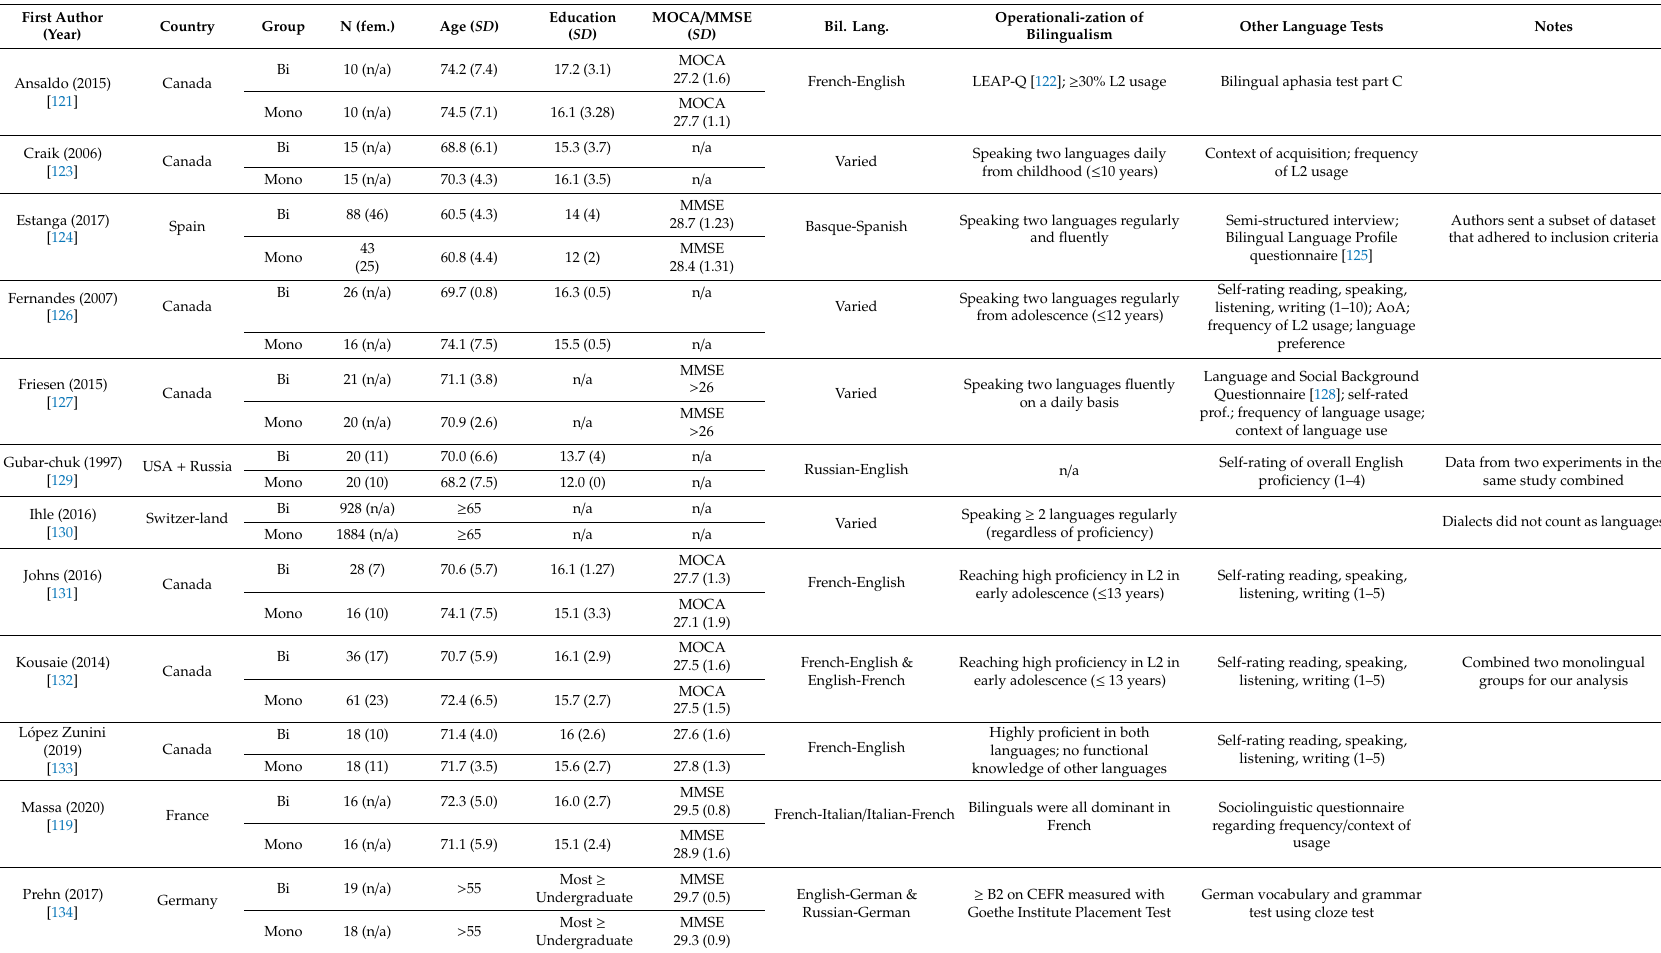
Table 3. Study characteristics of individual studies on cognitive function in bilingualism and in language learning interventions. Demographic information includes where the study took place, participants’ age and gender, educational background, and performance on Montreal cognitive assessment or the mini-mental state examination (continued on next